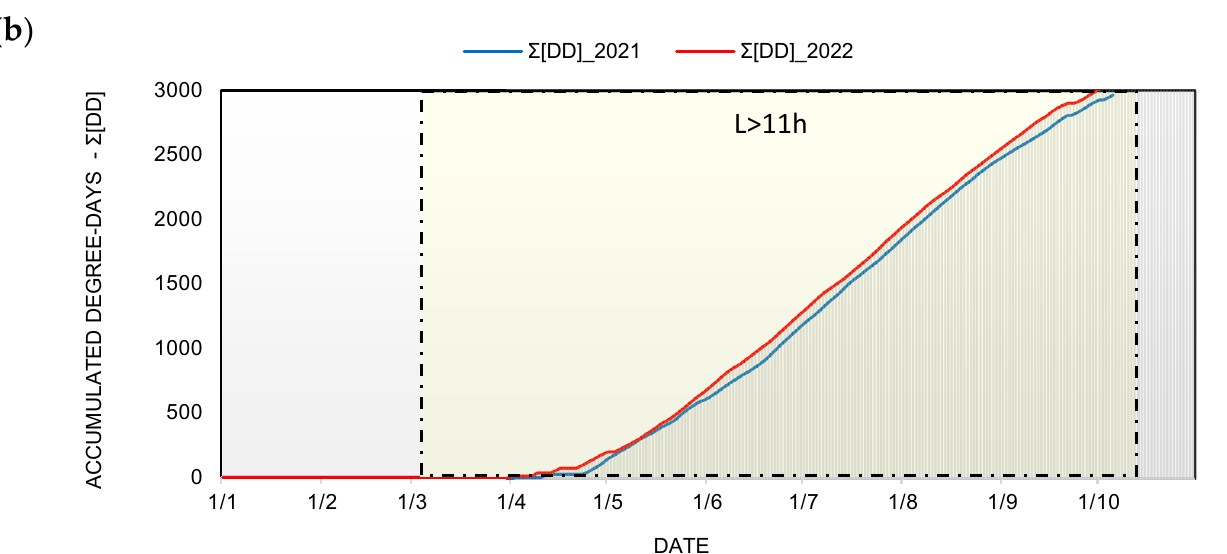
Figure 1. Field recordings of average daily temperatures ( a ) and accumulative degree days ( b ) dur- ing the growth seasons of 2021 and 2022 in the region of Prespa lakes in Northern Greece, and the respective dates were temperature and photoperiod conditions are favorable for T. urticae develop- ment.